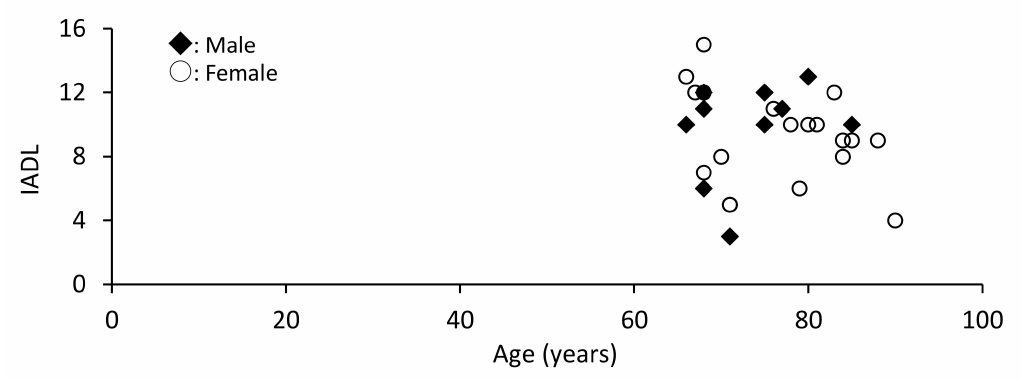
Figure 1. Association between age and instrumental activities of daily living (IADL) by sex.